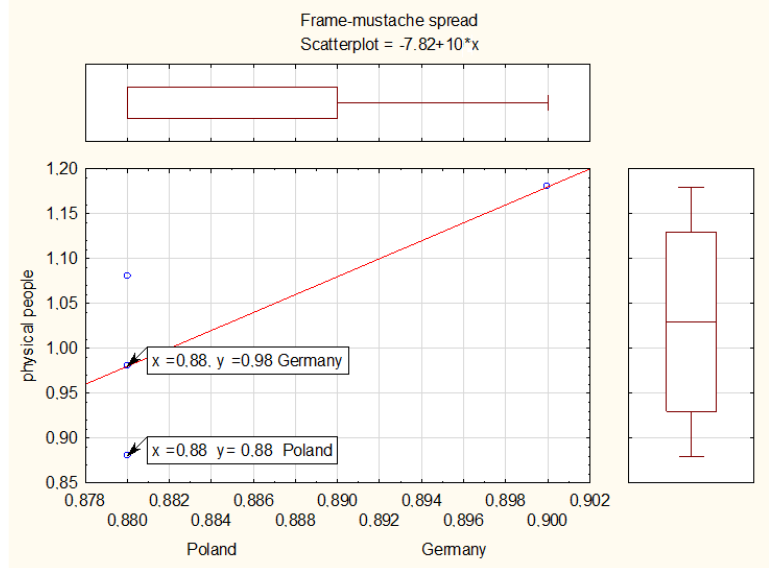
Figure 24. Chart showing the effectiveness of the implementation of the hydrogen assumptions in Poland and Germany based on the opinions of the